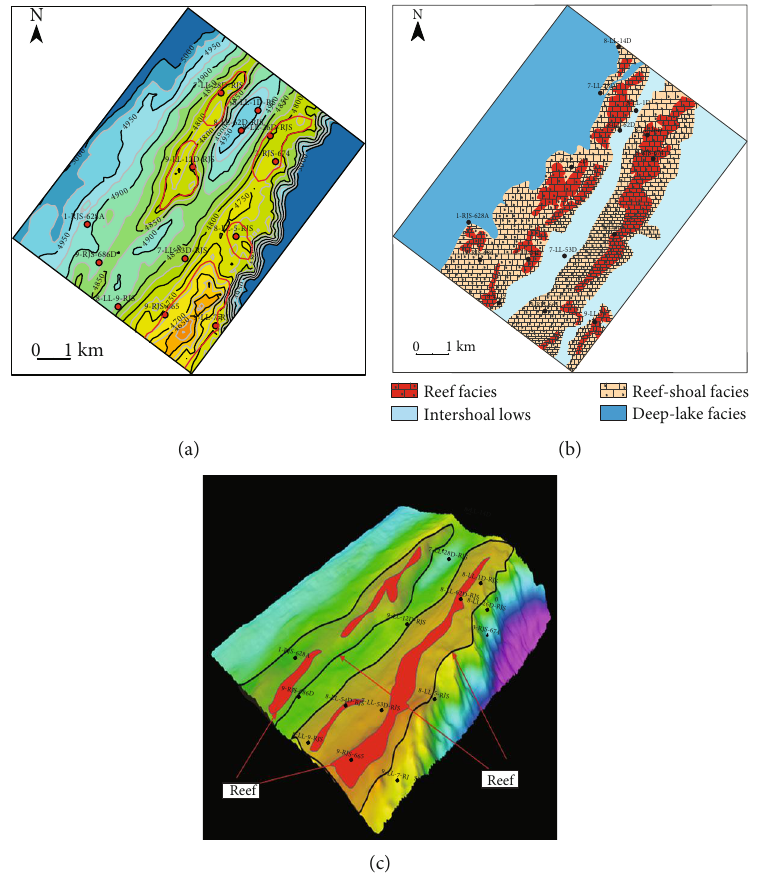
Figure 17: (a) Contour map and trap distribution of the top interface structure of the BVE100 layer, (b) reef-shoal facies reservoir and structural overlap map, and (c) sedimentary facies